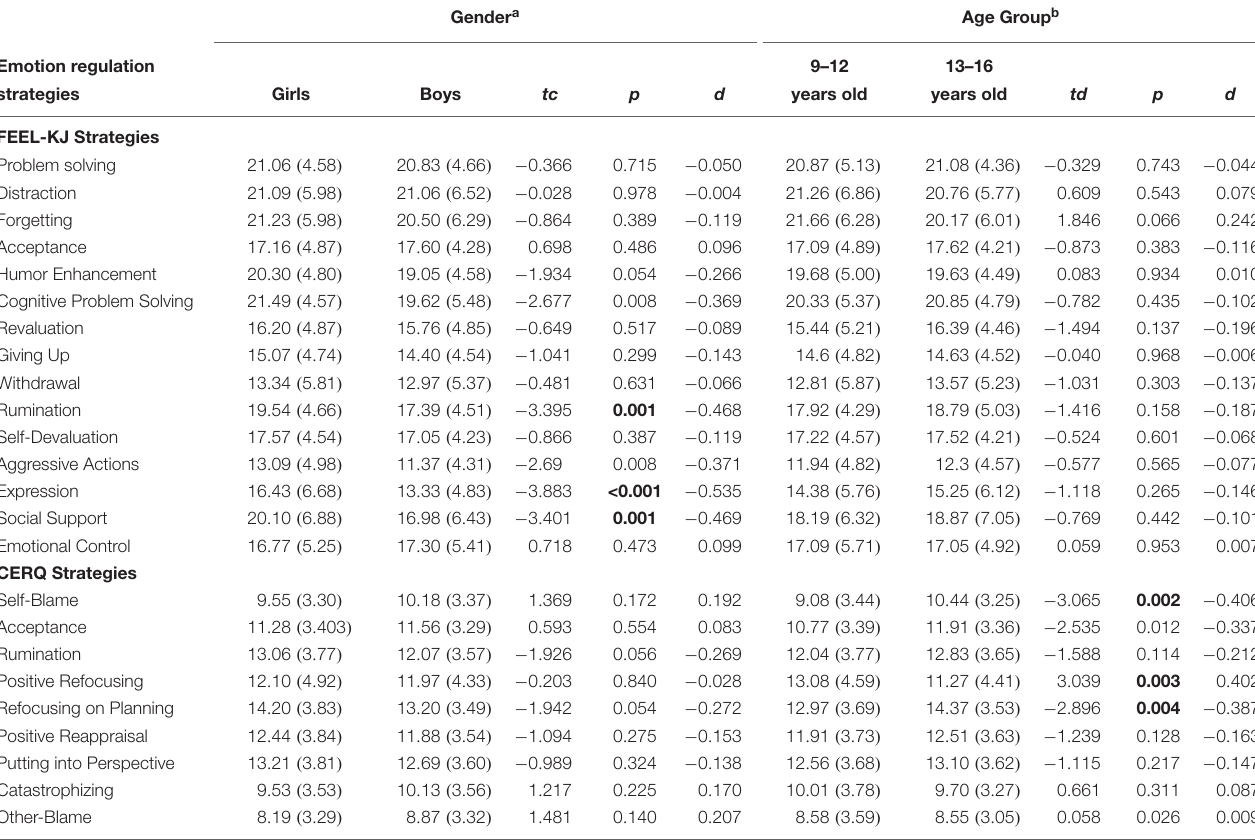
TABLE 4 | Mean differences on the FEEL-KJ and CERQ emotion regulation strategies scores by gender and age group. Gender a Age Group b